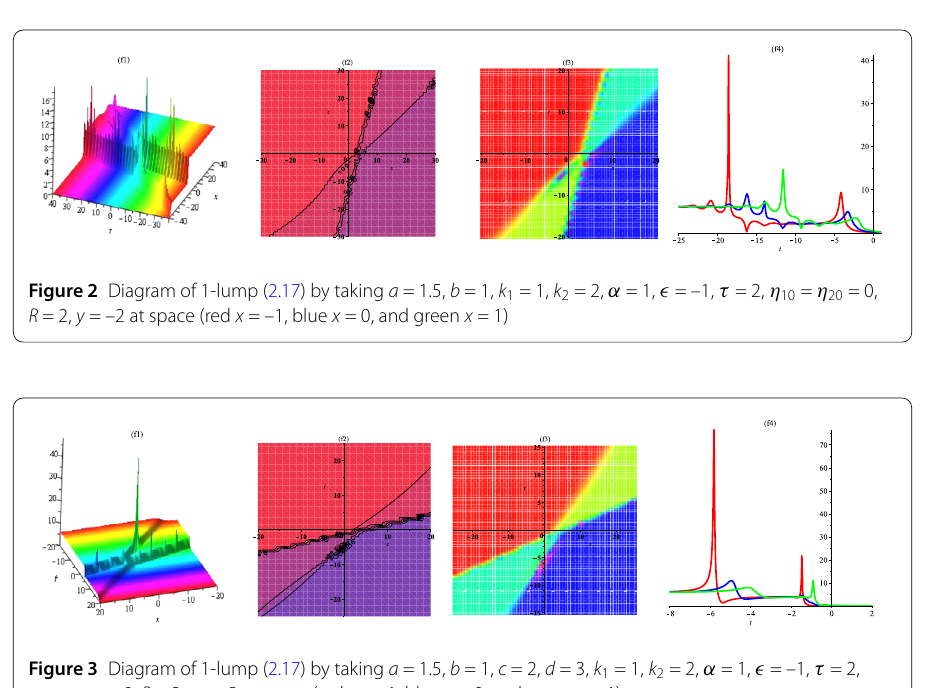
10 = η 20 = 0, R = 2, y = –2 at space (red x = –1, blue x = 0, and green x =